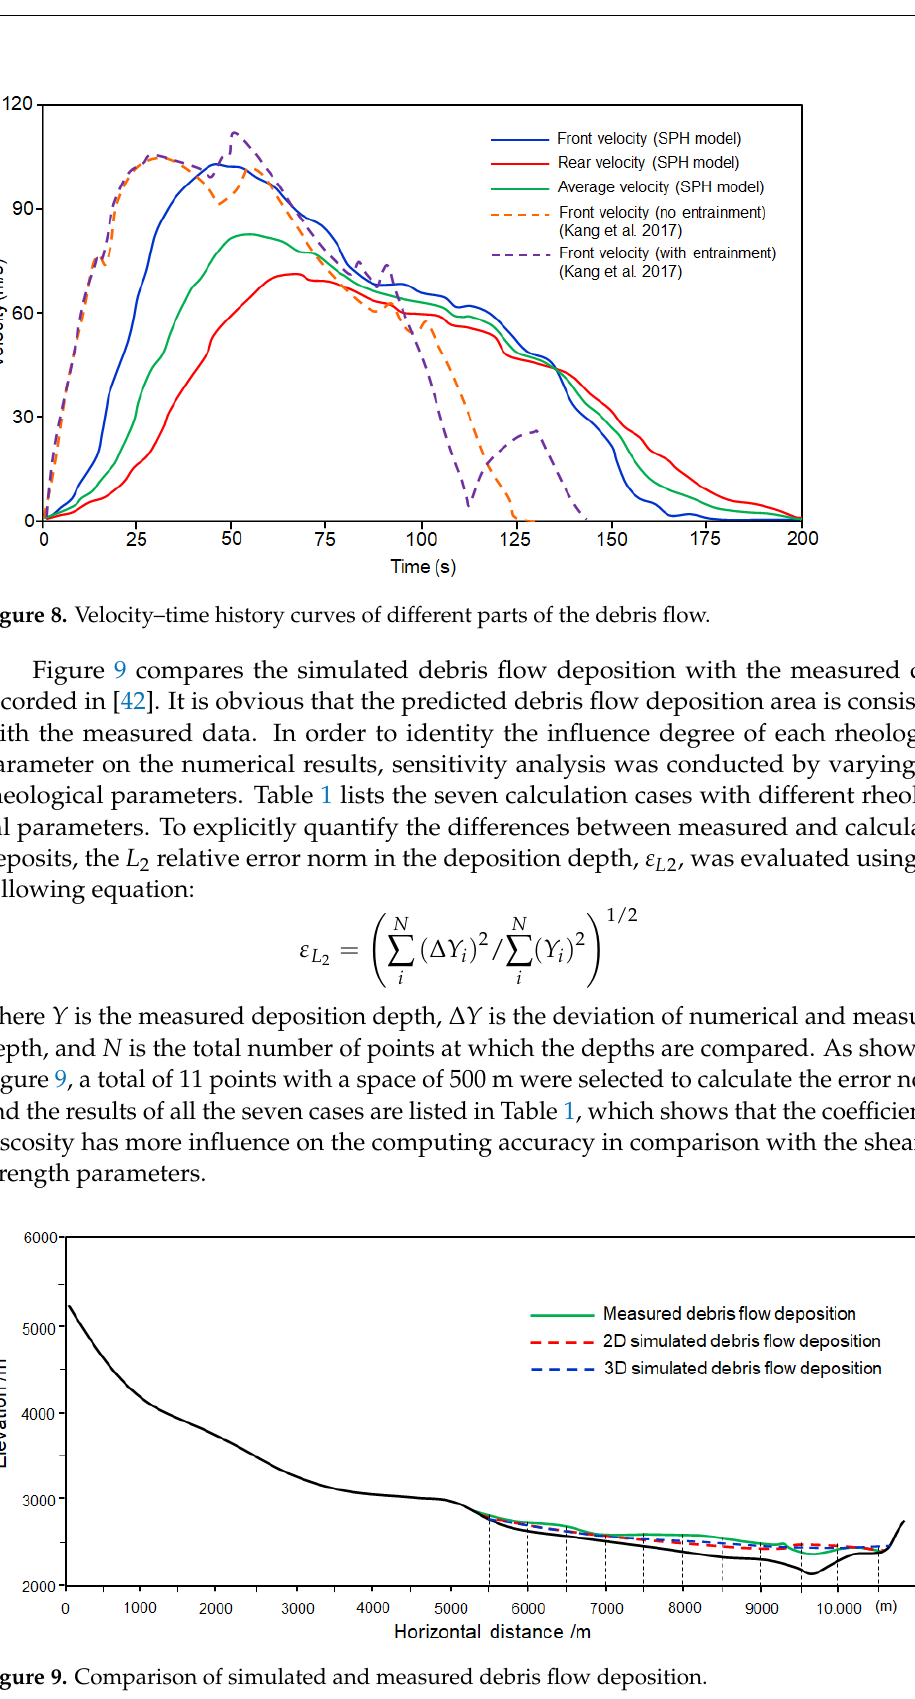
Figure 9. Comparison of simulated and measured debris flow deposition.